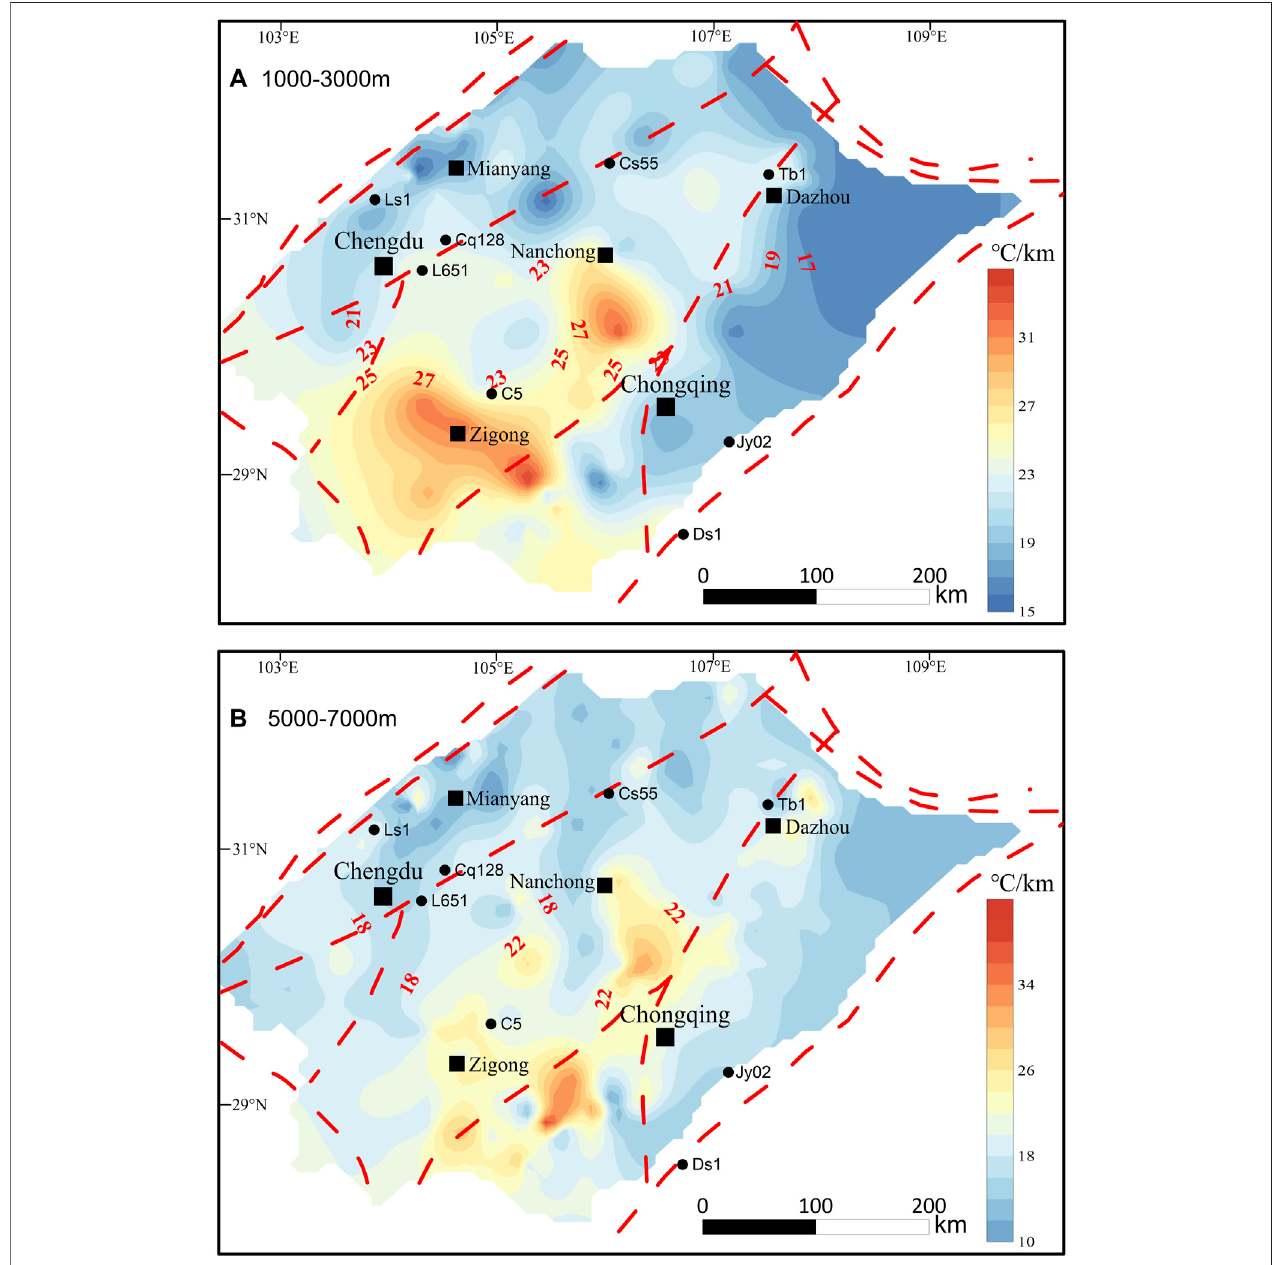
FIGURE 5 | Temperature gradient distribution within the depth of 1,000m – 3000 m (A) and 5,000m – 7000 m (B) in the Sichuan Basin.